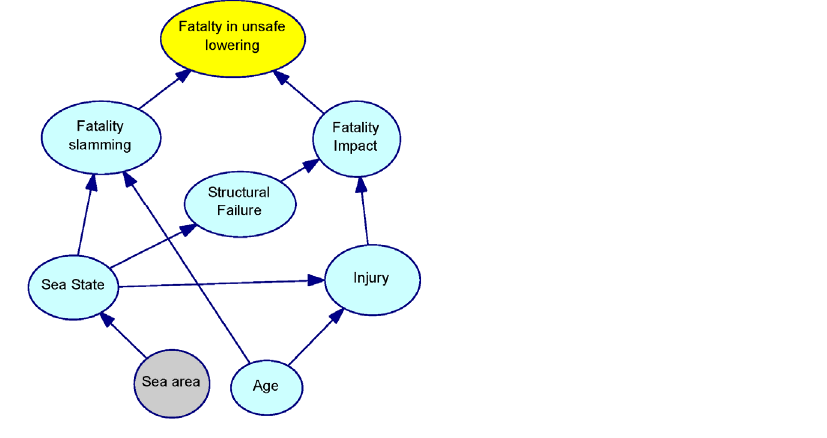
Figure A10. A Bayesian network for fatalities in unsafe lowering in both flooding and fire/explosion accidents (09a).